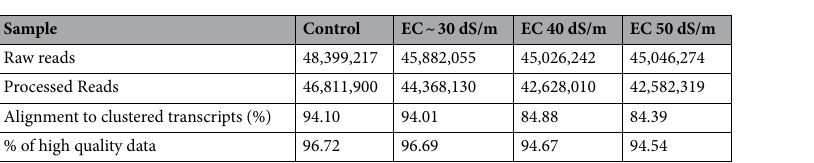
Table 3. Statistics of transcriptome sequencing results in Urochondra